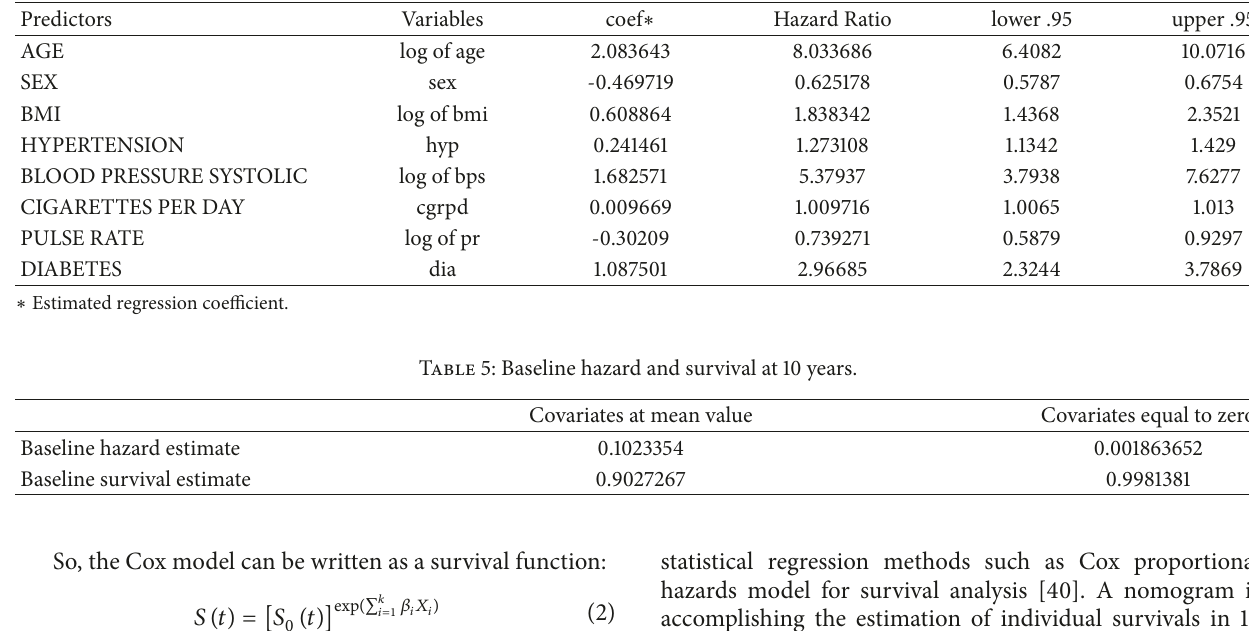
Table 4: Regression coefficients and hazard ratios in risk model.